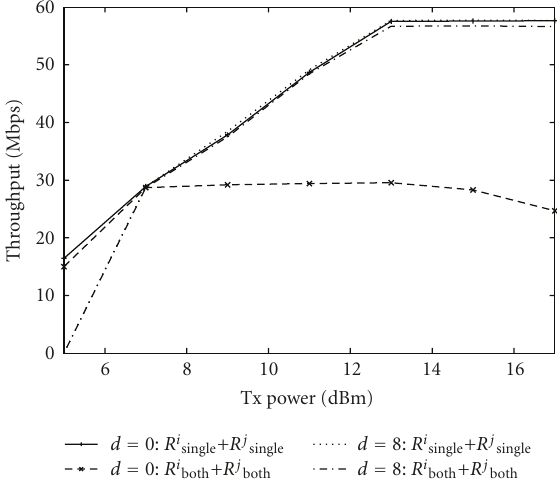
Figure 14: 802.11a links: impact of the channel distance and transmission power on the total